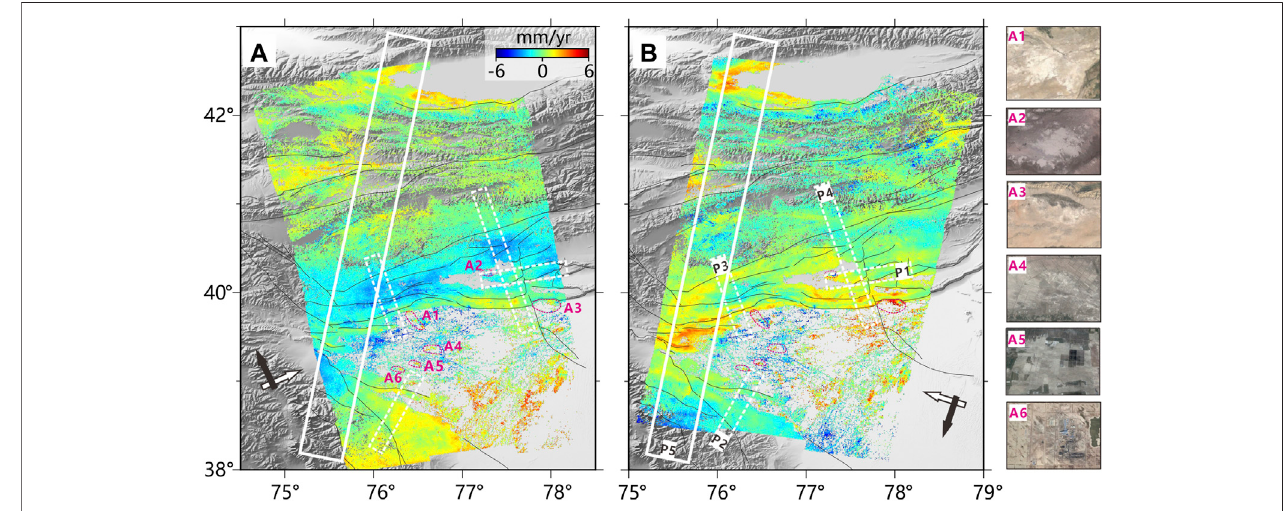
FIGURE 2 | Line-of-sight (LOS) velocity map of the tracks 129 (A) and 34 (B) .